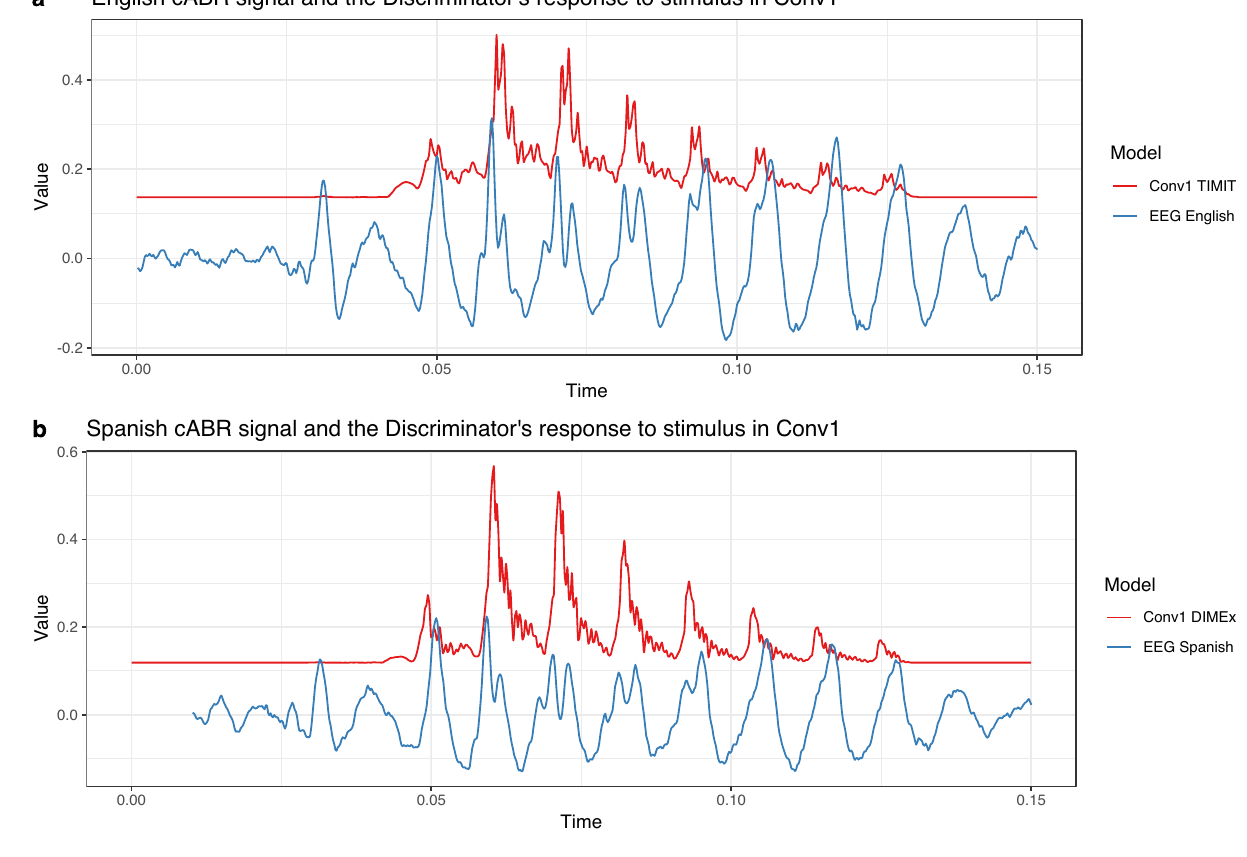
Figure 3. ( a ) Values of the English cABR experiment averaged across subjects (blue) and values of the first convolutional layer in the TIMIT-trained model (Conv1 TIMIT) averaged across replications when the Discriminator gets the actual stimulus as the input (red). The two time series are aligned such that the peaks corresponding to the burst have the same timing. The values of the Conv1 signal are increased 50-times for comparison. ( b ) Values of the Spanish cABR experiment averaged across subjects (blue) and values of the first convolutional layer in the DIMEx-trained model (Conv1 DIMEx) averaged across replications when the Discriminator gets the actual stimulus as the input (red). The two time series are aligned such that the peaks corresponding to the burst have the same timing. The values of the Conv1 signal are increased 50-times for